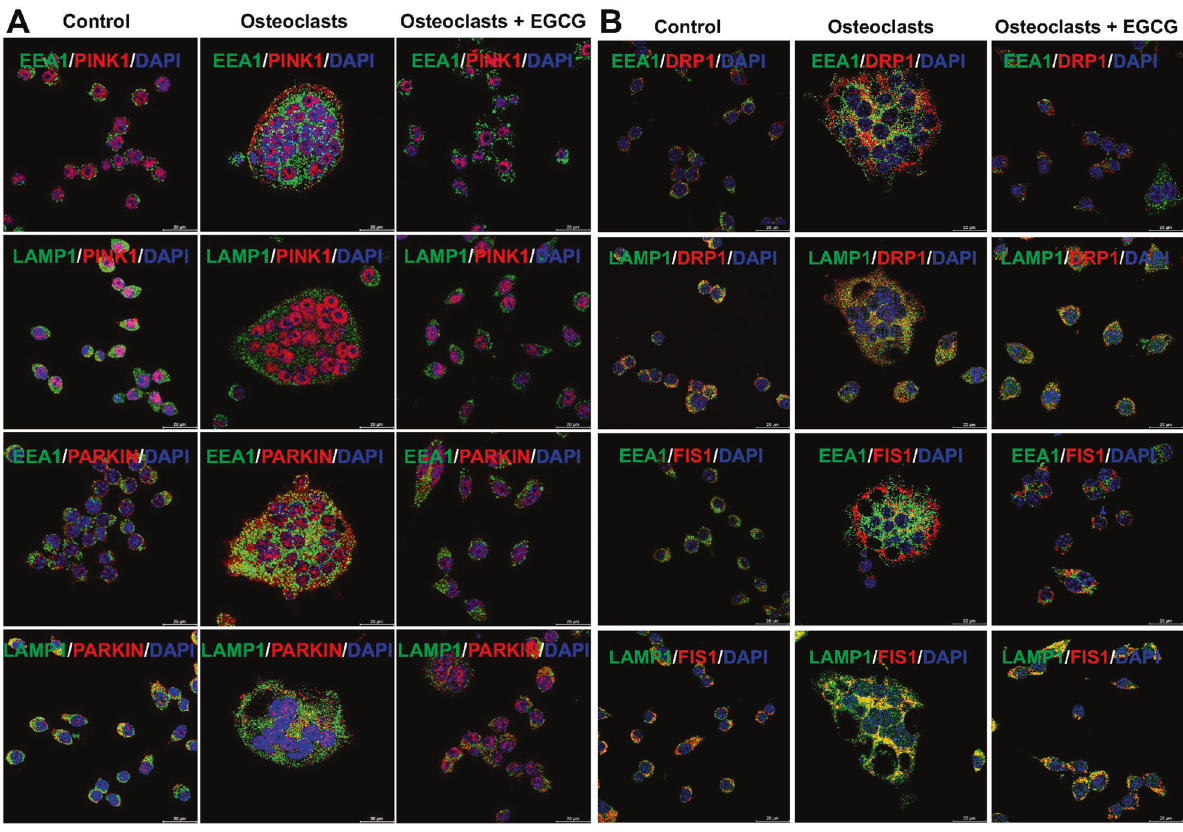
Fig. 4 Effect of EGCG in the intracellular traf fi cking of mitophagy- and mitochondrial fi ssion-related molecules. A Representative co- immunostaining images are presented for PINK1 and PARKIN with EEA1 or LAMP1. B Representative co-immunostaining images are presented for DRP1 and FIS1 with EEA1 or